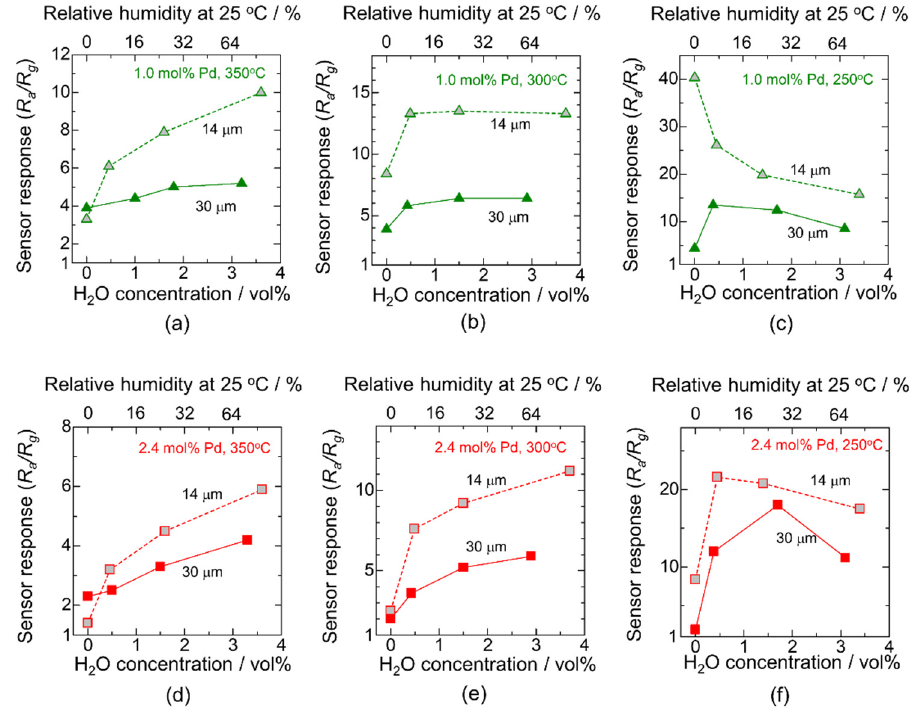
Figure 9. H 2 O concentration dependence of the sensor response to 200 ppm CO at ( a , d ) 350 °C, ( b , e ) 300 °C, and ( c , f ) 250 °C using ( a – c ) CP-1.0Pd/SnO 2 and ( d – f ) CP-2.4Pd/SnO 2 with different thicknesses of the sensing layer, 14 and 30 μ m.